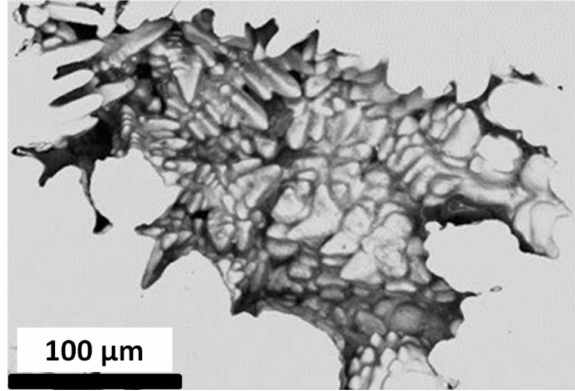
Figure 1. Micro-shrinkage